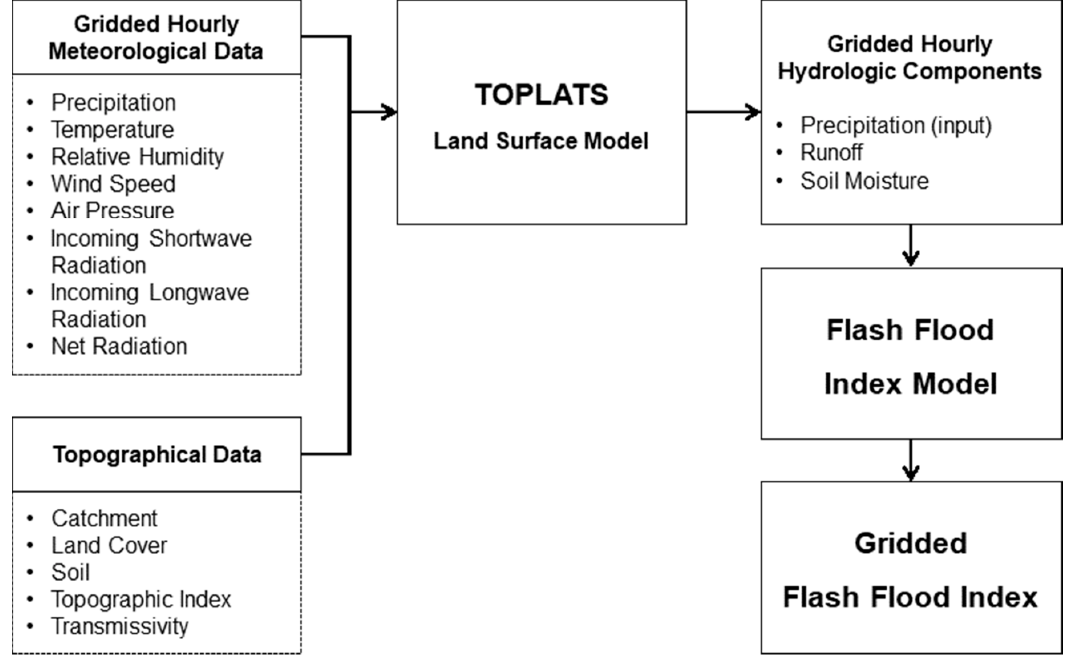
Figure 1. Schematic architecture of the statistical flash flood index forecasting system. If there are multiple panels, they should be listed as: ( a ) Description of what is contained in the first panel; ( b ) Description of what is contained in the second panel. Figures should be placed in the main text near to the first time they are cited. A caption on a single line should be centered.